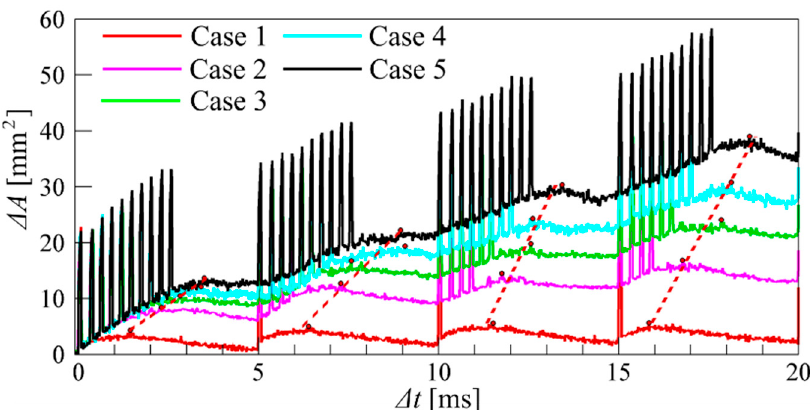
Figure 6. Area of the thermal perturbation. The spikes denote the virtual increase of the thermal perturbation due to the shock wave generating from the plasma actuator.